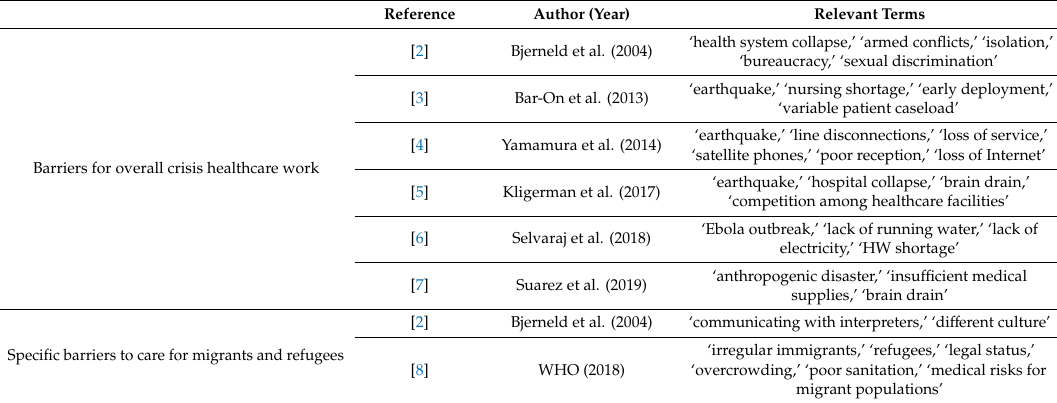
Table 1. Medical system infrastructure and patient